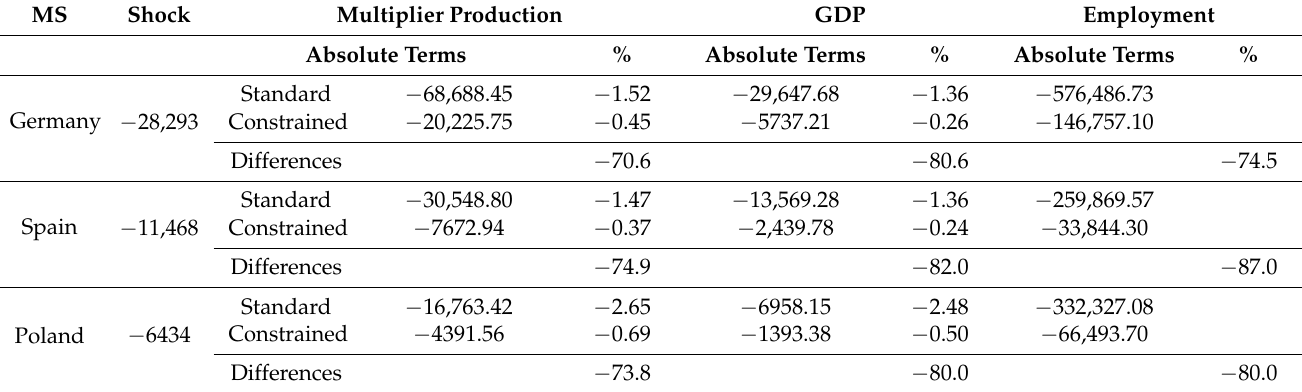
Table 4. Economic impact of FLW reduction by HH (millions of euros, percentage, number of